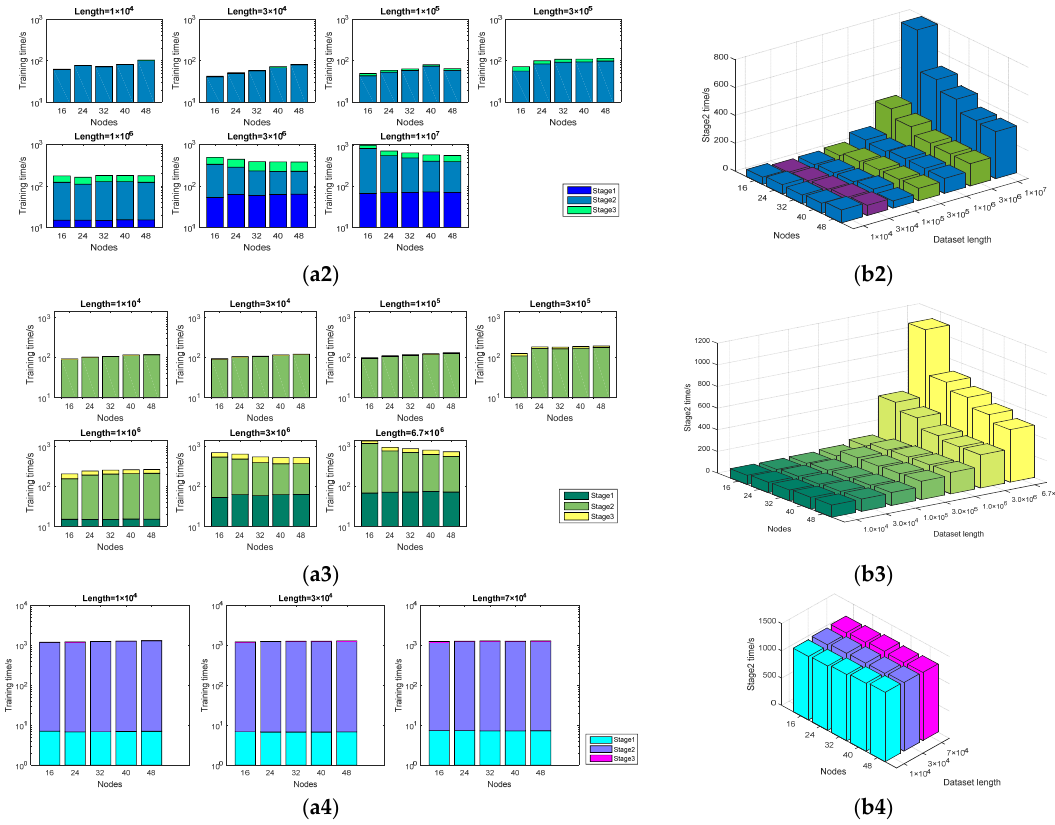
Figure 6. Training time of four datasets from top to bottom. ( a1–a4 ) Training time of each dataset in different lengths and nodes, which is stacked by three stages. Logarithmic scale is used for convenience. ( b1–b4 ) Time spent on iterations (stage 2).